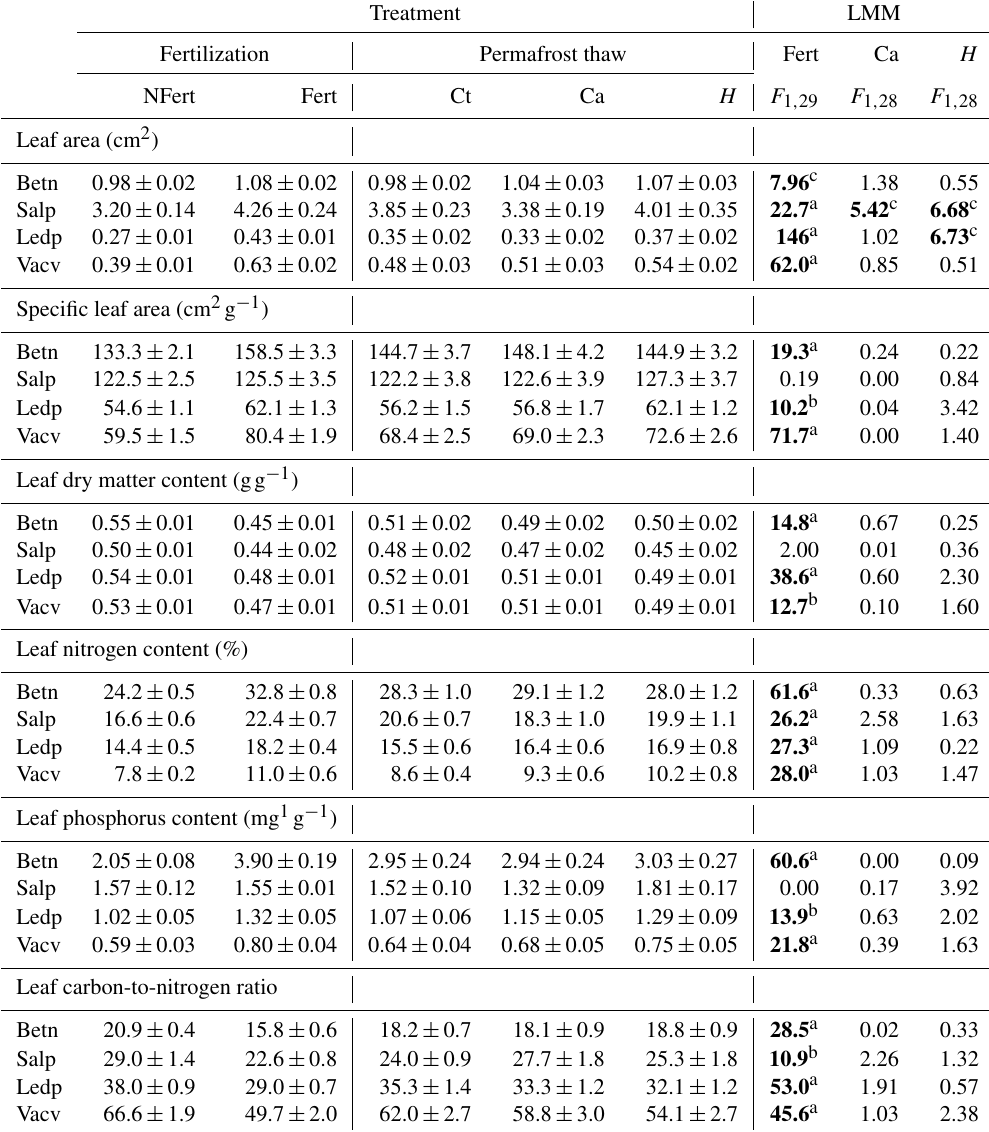
Table 2. Effects of fertilization (Fert), cable disturbance (Ca) and soil heating ( H ) on leaf traits of each shrub species ( B. nana (Betn), S. pul- chra (Salp), L. palustre (Ledp) and V. vitis-idaea (Vacv)). Treatment columns show the average and standard error of the response variables for no fertilization (NFert), fertilization (Fert), no heating cables (Ct), unheated cables (Ca) and heated cables (H). LMM columns show the Wald test outputs for our linear mixed-effect models. Significant effects are in bold. Treatment combination effect (heating × nutrient addition) was not included as it was significant only for LA of Betn ( F 1 , 25 = 15.1, P <